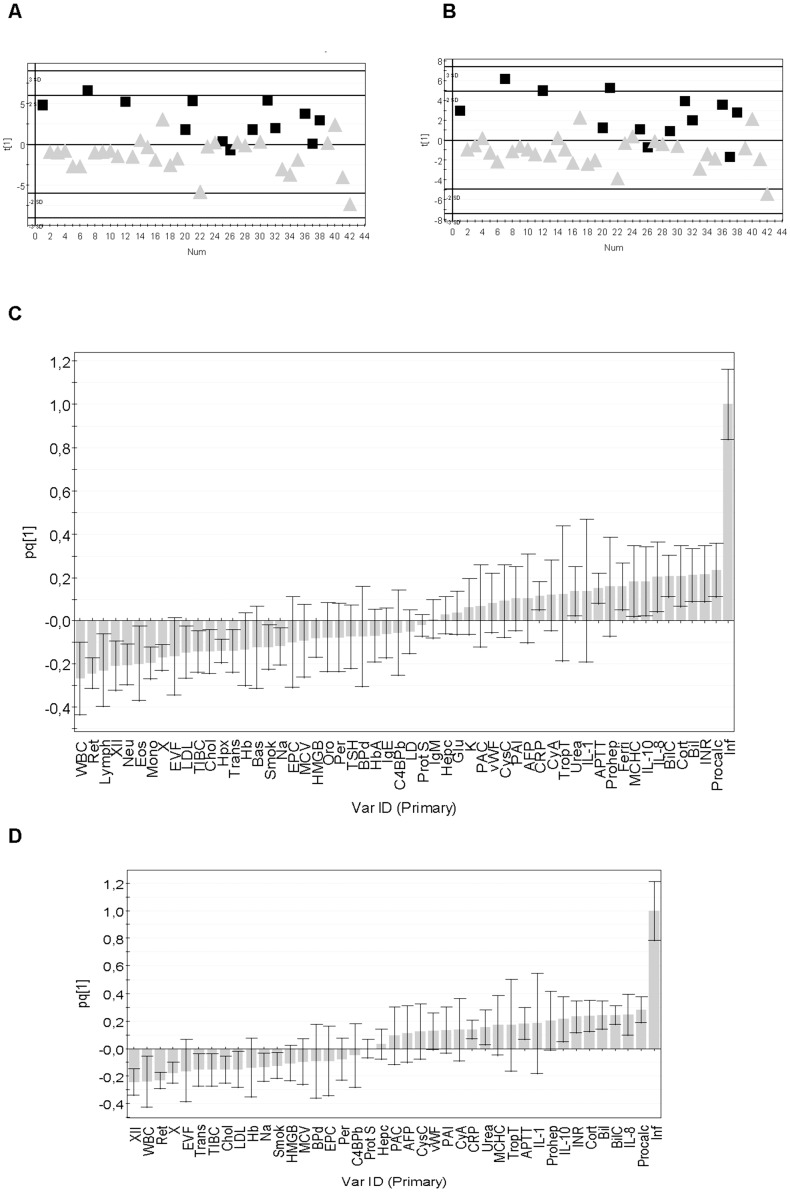
Pattern recognition models can separate infected from non-infected hematology patients with neutropenic fever.(A) O-PLS scatter plot showing how the patients (n = 42) separate in a model based on 139 parameters; black symbols denote patients with proven infection, grey symbols those without proven infection. “Num” on the X-axis indicates arbitrary number assigned to each patient. The Y-axis measure, t [1], indicates the probability of being infected according to the model. The model had an explanatory power of 47% (R2Y = 0.47) but poor cross-validation (Q2Y = −0.0082). (B) Scatter plot of a model based on 55 of the original 139 variables; variables of low importance (VIP values <1.0) were removed. R2Y = 0.50, Q2Y = 0.32. (C) Column loading plot showing how the 55 variables contribute to the model shown in B. Variables positively associated with infection (Inf) are positioned above the line in the right half of the diagram, those that correlate negatively with infection are positioned below the X-axis. The larger the bar, the larger is the contribution made by the variable to the model. The smaller the confidence interval (error bar), the more certain is the contribution of the variable in question. (D) Loading plot of the model based on 40 variables. R2Y = 0.47, Q2Y = 0.30.